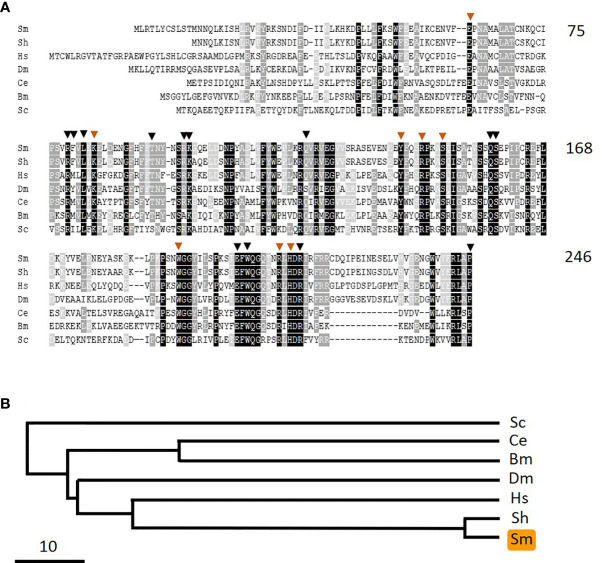
Alignment of SmPNPO with other members of the pyridox(am)ine 5’-phosphate oxidase protein family. Sm, Schistosoma mansoni (GeneBank accession number MW148601); Sh, Schistosoma haematobium (XP_012792194); Hs, Homo sapiens (NP_060599); Dm, Drosophila melanogaster (NP_731186.2); Ce, Caenorhabditis elegans (NP_498518); Bm, Brugia malayi (XP_001896760); Sc, Saccharomyces cerevisiae (AJQ03502). Residue shading is as described in
Figure 6
. Residues predicted to be important in pyridoxal phosphate binding are indicated by brown arrowheads and those involved in binding the cofactor flavin mononucleotide are indicated by black arrowheads. Numbers at right are an amino acid count for the S. mansoni protein. (B) Phylogenetic tree (absolute distance) of selected pyridox(am)ine 5’-phosphate oxidases generated by multiple sequence alignment using UPGMA (unweighted pair group method with arithmetic mean). The designations (and accession numbers) of the homologs compared are as in (A).